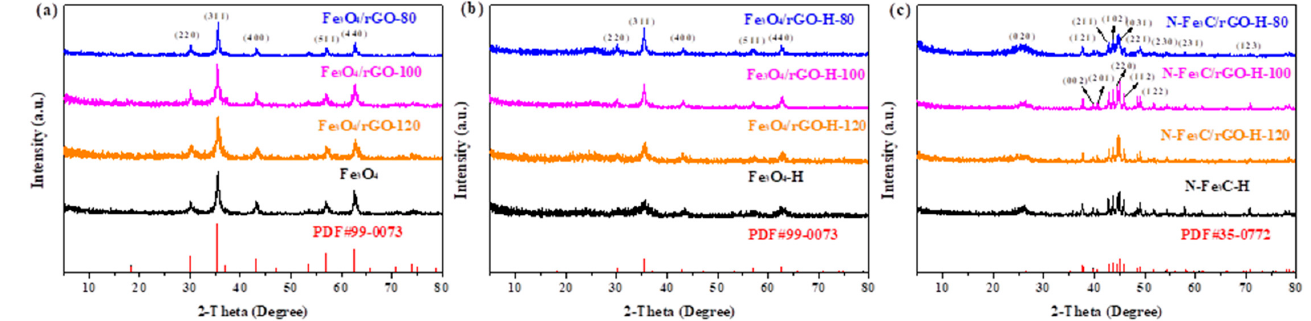
Figure 1. SEM images of ( a ) N-Fe 3 C/rGO-H-80, ( b ) N-Fe 3 C/rGO-H-100, ( c ) N-Fe 3 C/rGO-H-120, ( d ) N-Fe 3 C/rGO-H-700, ( e ) N-Fe 3 C/rGO-H-900, and ( f ) N-Fe 3 C-H. Figure 2a,b show the XRD patterns of Fe 3 O 4 /rGO before and after etching with strong acid. The diffraction peaks are located at 30.0°, 35.4°, 43.1°, 56.9° and 62.5° according to the (220), (311), (400), (511) and (440) Fe 3 O 4 crystal planes (PDF#99-0073), respectively. It was observed that the crystal planes did not change before and after etching, but the peak intensity was slightly weakened. XRD patterns of N-Fe 3 C/rGO-H obtained by calcination of Fe 3 O 4 /rGO doped with dicyandiamine at high temperature are shown in Figure 2c. The 2 θ positions of the peaks are at 26.4°, 37.6°, 39.8°, 40.6°, 42.8°, 43.7°, 44.5°, 44.9°, 45.8°, 49.1°, 51.8°, 54.4°, 58.4° and 70.8° corresponding to Fe 3 C’s (020), (121), (002), (201), (211) (102), (220), (031), (112), (221), (122), (230), (231) and (123) sides of Fe 3 C (PDF#35-1-0772), respec- tively. The XRD results demonstrate the successful preparation of Fe 3 O 4 NPs by pyrolysis of iron oleate precursors, which were converted to Fe 3 C by sintering at high temperature after nitrogen doping. The XRD of the comparison samples N-Fe 3 C/rGO-H-700 and N- Fe 3 C/rGO-H-900 are shown in Figure S3, and the calcination temperature has no effect on the formation of the crystalline phase of Fe 3 C. Figure 2. XRD patterns of ( a ) Fe 3 O 4 /rGO, ( b ) Fe 3 O 4 /rGO-H and ( c ) N-Fe 3 C/rGO-H. TEM further observed the morphological changes of Fe 3 O 4 /rGO before and after strong acid etching and nitrogen-doped high-temperature calcination. Figure 3a shows the integration of nanoparticles on the carrier surface after calcination of Fe 3 O 4 NPs and rGO components at 500 °C. Since the number of nanoparticles anchored on the carrier surface was limited, the excess and poorly anchored particles on the rGO surface were etched off with 1 M HCl, as shown in Figure 3d. Observation of the pictures revealed that the remaining Fe 3 O 4 NPs were more uniformly dispersed on the carrier surface after the accumulation of particles in rGO was successfully etched off. Then, dicyandiamide was added and scorched at 800 ◦ C. The Fe atoms overflowed on the rGO surface, leaving a hollow shell (Figure 3g). These shell structures may become the active sites of the CO 2 RR. In addition, the Fe 3 O 4 /rGO-100 and Fe 3 O 4 /rGO-H-100 grain sizes are approximately 10.2 ± 1.2 nm and 9.73 ± 1.2 nm, respectively, and the grain size of the empty shells is approximately 6.74 ± 1.2 nm. The grain size data indicate that the decrease in the number of iron atoms on the substrate and the high-temperature carbonization cause the nanoparticle size and the size of the empty shells to gradually decrease. By measuring the lattice stripes in the HRTEM of Fe 3 O 4 /rGO-100, Fe 3 O 4 /rGO-H-100 and N-Fe 3 C/rGO-H-100 as 0.241 nm, 0.200 nm and 0.288 nm, 0.195 nm responding to the (222), (400), (220) planes of Fe 3 O 4 and (112) faces of Fe 3 C, respectively. The diffraction rings of Figure 3c,f,i illustrate that all three nanoparticles are polycrystalline in structure. The energy-dispersive X-ray